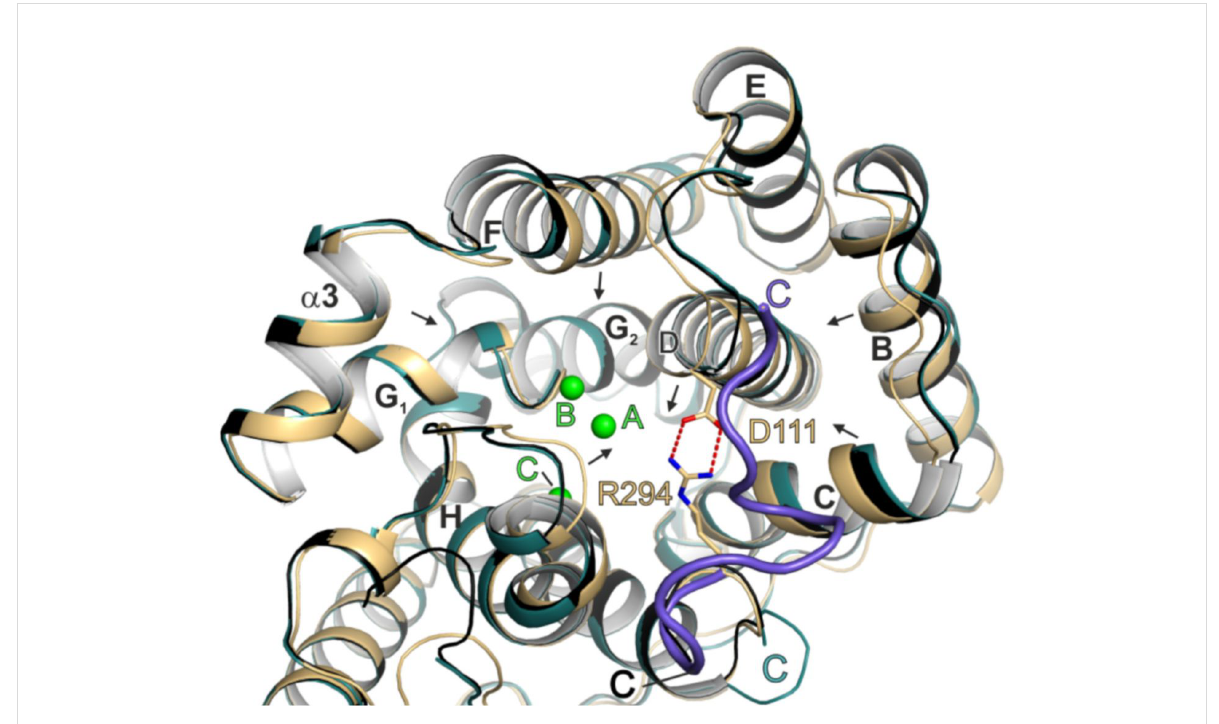
Figure 3: Conformational changes of CotB2 upon ligand binding. Superposition of CotB2’s open (teal), pre-catalytic (black, CotB2 wt ·Mg 2+ B ·GGSDP), and fully closed (light-brown, CotB2 wt ·Mg 2+ 3 ·F-Dola) conformation. The overall fold of CotB2 wt ·Mg 2+ B ·GGSDP (PDB-ID 5GUE; [36]) is more similar to CotB2 wt (PDB-ID 4OMG; [38]) than to CotB2 wt ·Mg 2+ 3 ·F-Dola (PDB-ID 6GGI; [37]). The salt bridge between D111 and R294, in stick representation, is shown by red, dashed lines. Mg 2+ ions are colored in green. Black arrows indicate movement of secondary structure elements from the open to the closed conformation of CotB2. The different C-termini are labeled in all three structures. The C-terminus in the structure of CotB2 wt ·Mg 2+ 3 ·F-Dola is colored in